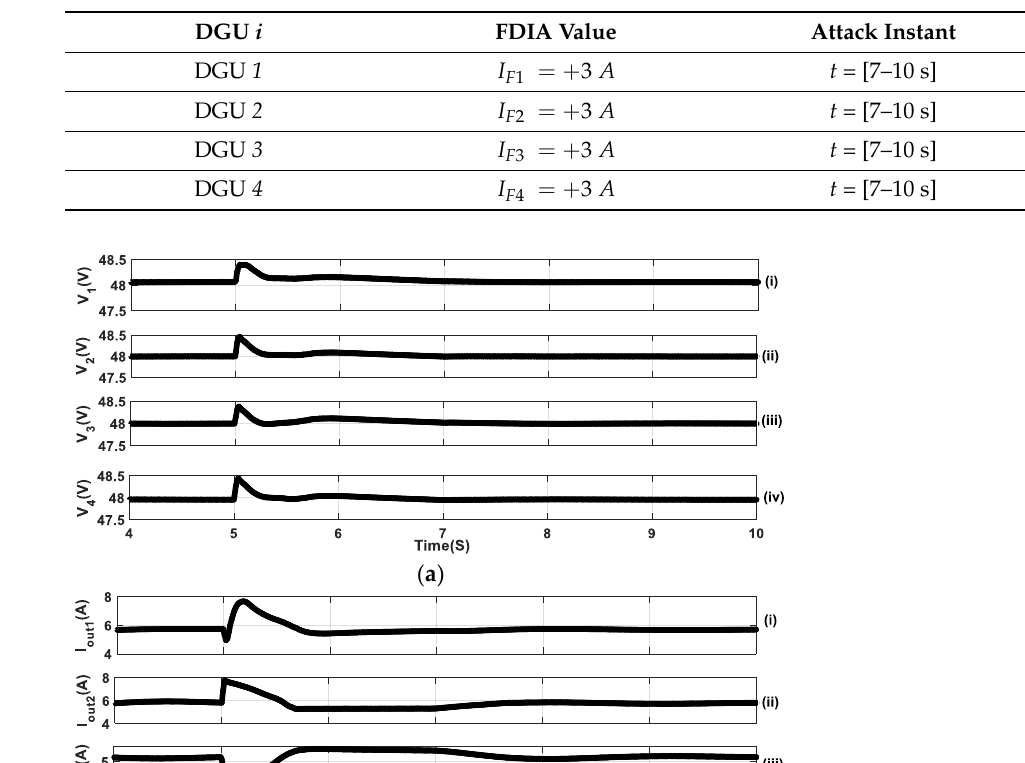
Table 6. Simultaneous current FDIA parameters.